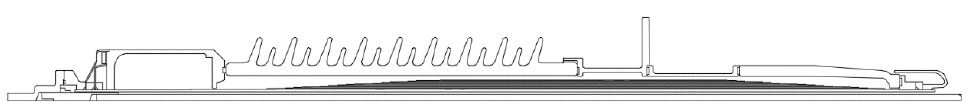
Figure 9. Finite element model of 72.5 kV transformer bushing.